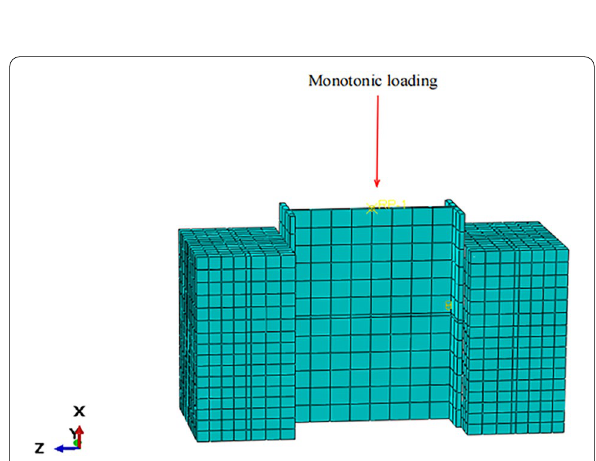
Fig. 16 Finite element model.